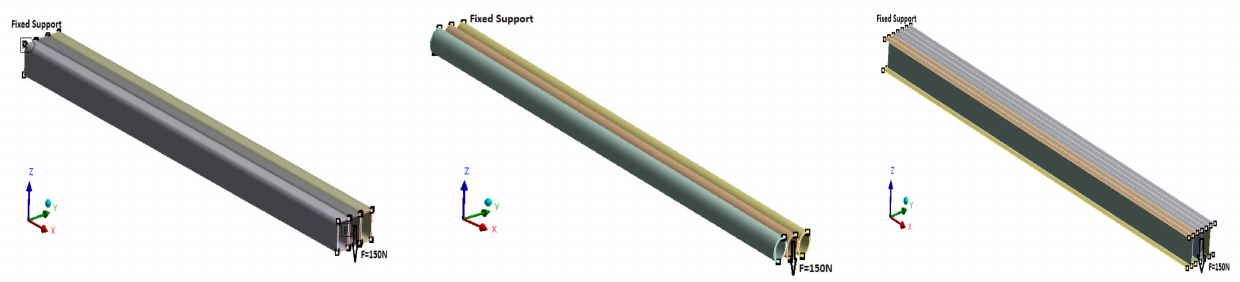
Figure 12. Proposed multi-cell beams (based on the design charts) subjected to bending loads. Cross sections are three rectangular beams ( RRR ), three oval beams ( OOO ), and three I-beams ( III